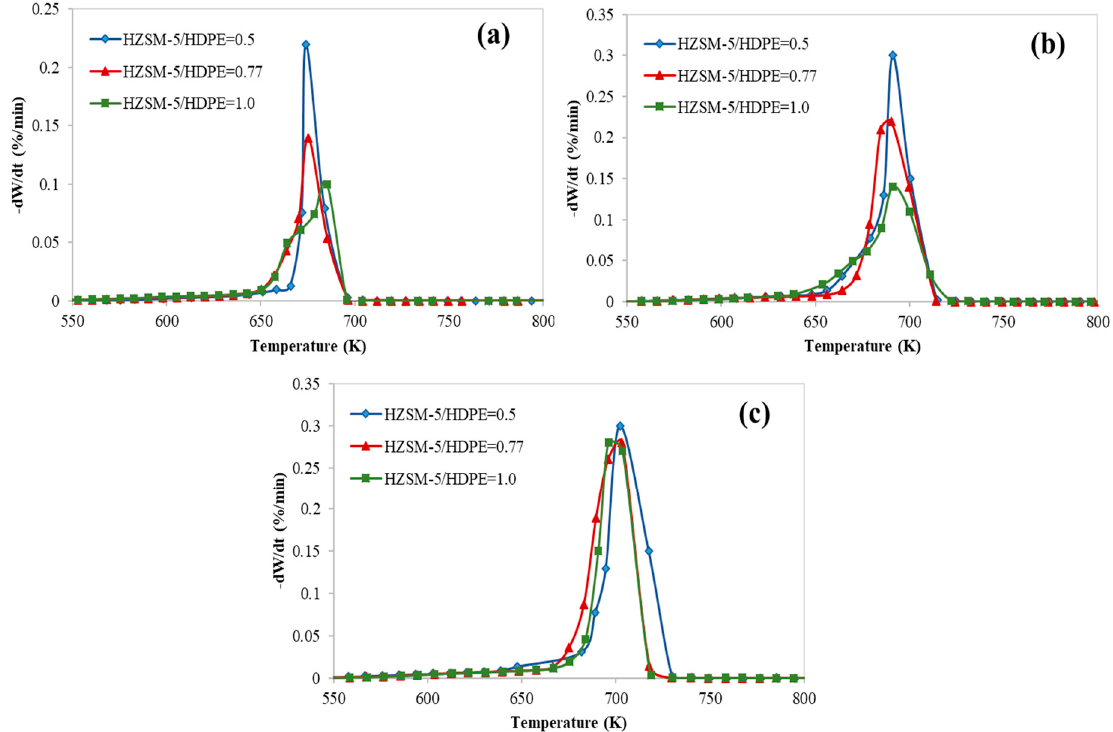
Figure 4. DTG curves at different heating rates: ( a ) 5 K/min, ( b ) 10 K/min, and ( c ) 15 K/min.